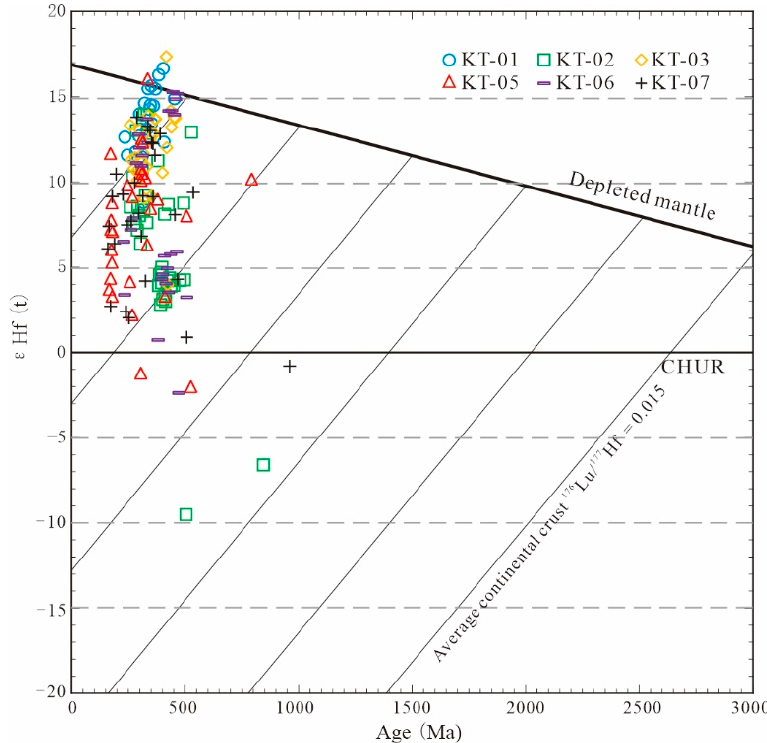
Figure 10. Plot of detrital zircon U––Pb ages versus ε Hf (t).